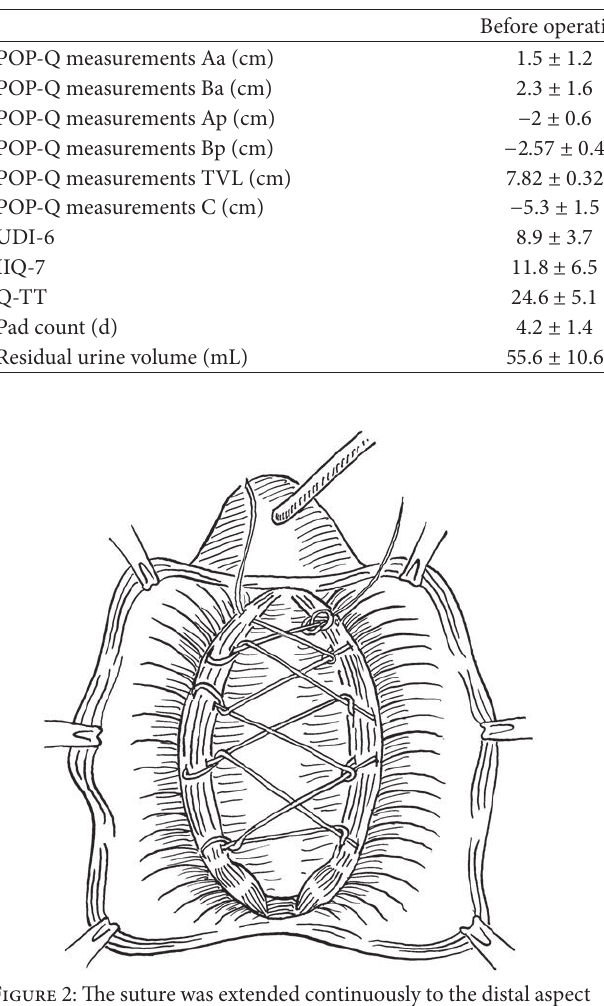
Table 2: POP-Q, incontinence-related quality values.